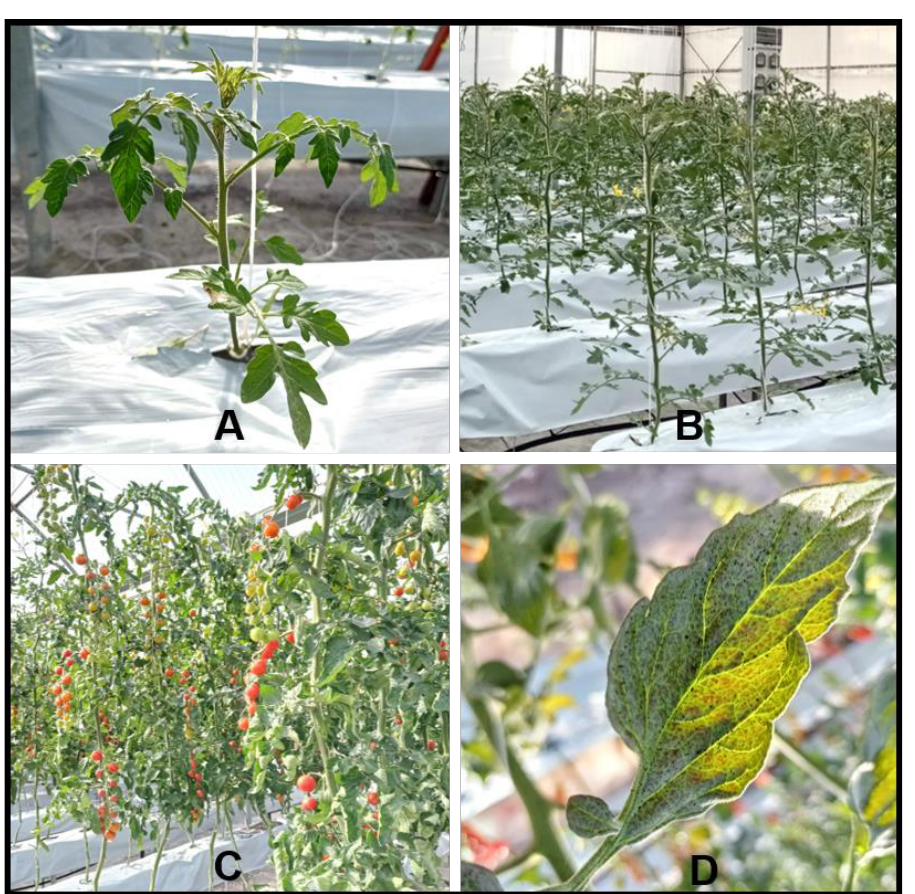
Figure 1. Different phases of the crop cycle during the experiments: ( A ) plant 7 days after transplanting; ( B ) flowering of the 1st cluster; ( C ) 1st cluster almost ready for harvest; ( D ) leaf showing dark spots ~72 days after transplanting.